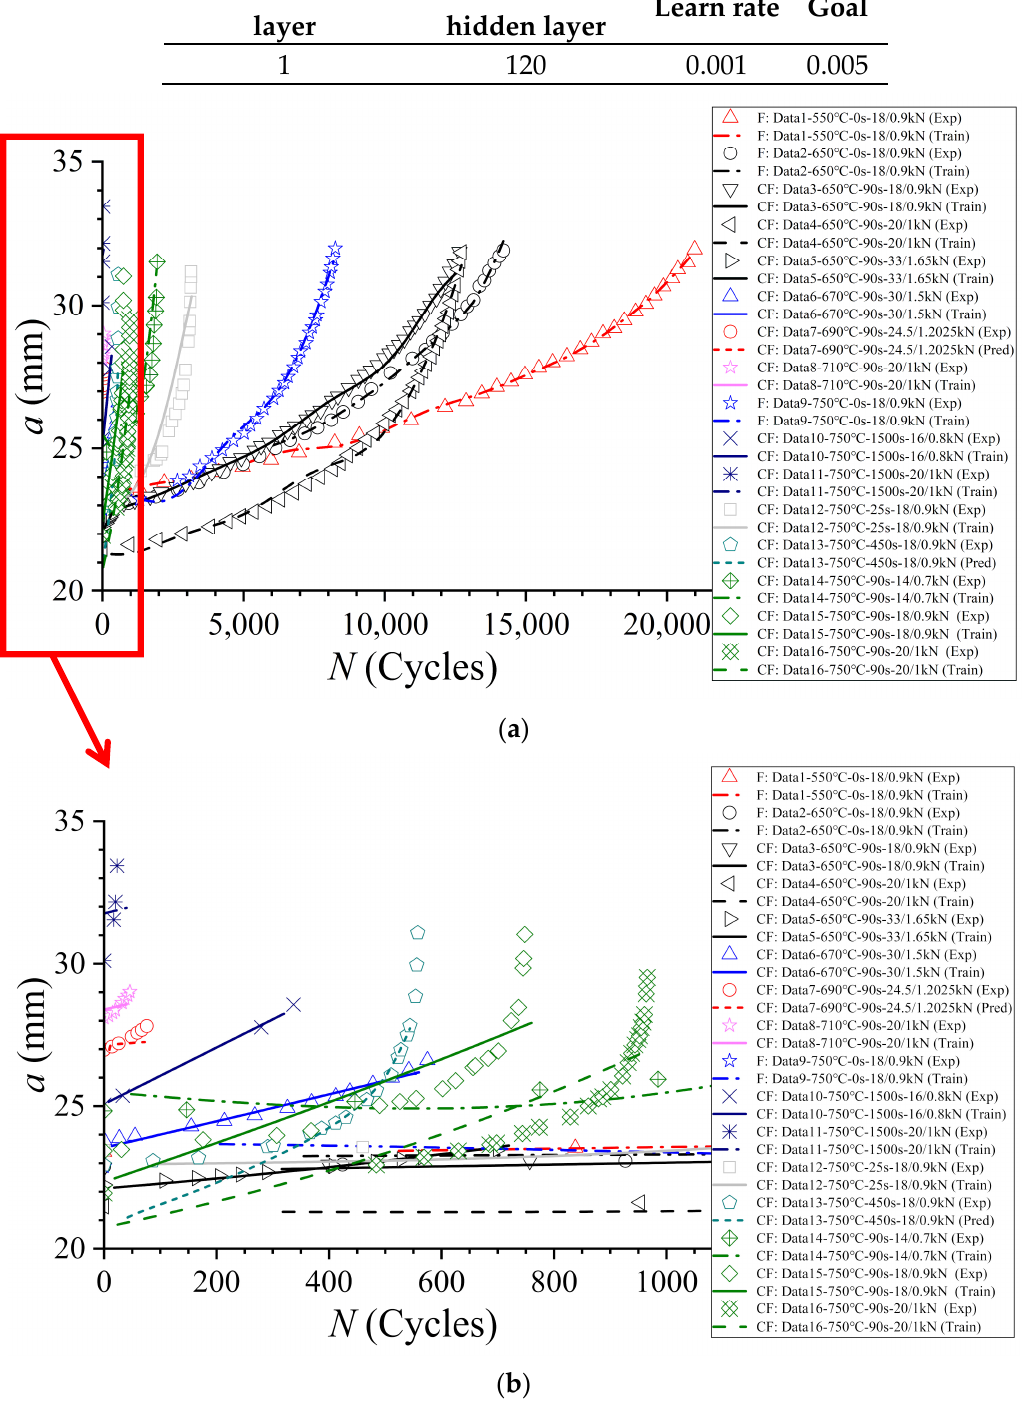
Figure 16. ( a ) a - N curves prediction using NNIL scheme for data measured under the different loading conditions, temperature and holding time; ( b ) zoom in image for N in the range from 0 to 1100 cycles.